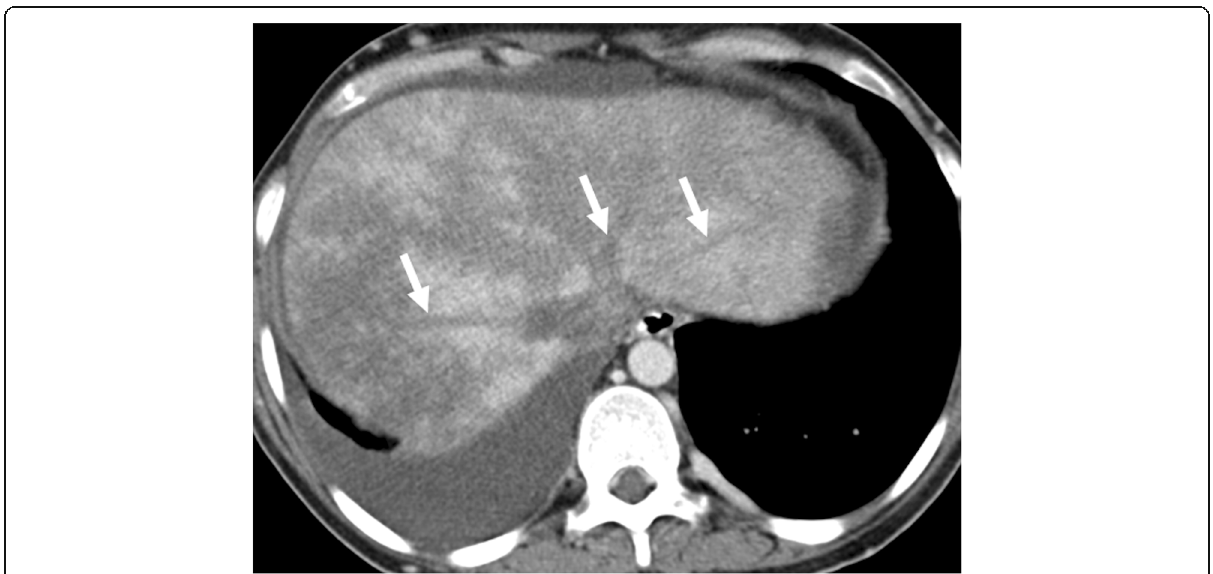
Fig. 7 Budd-Chiari syndrome. A 29-year-old female with known Behcet ’ s disease presented with acute and severe right upper quadrant pain and abdominal distension. Abdominal US study showed fresh thrombus within the hepatic veins (not shown). Subsequent venous phase axial CT scan shows thrombosed hepatic veins (arrows). The liver parenchyma demonstrated heterogeneous contrast enhancement with severe parenchymal